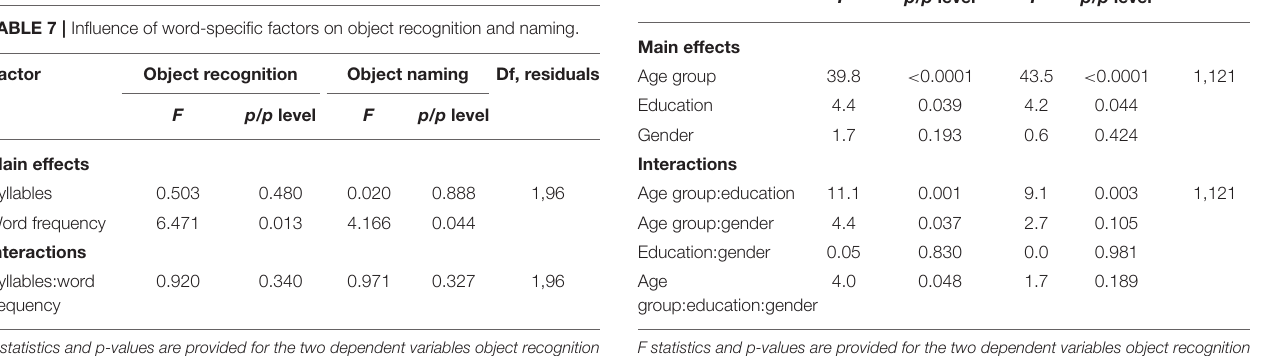
F statistics and p-values are provided for the two dependent variables object recognition and object naming.